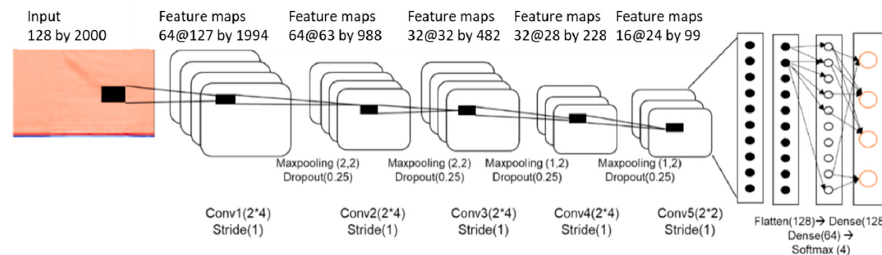
Figure 6. Two-dimensional CNN model for classification of cattle voice.